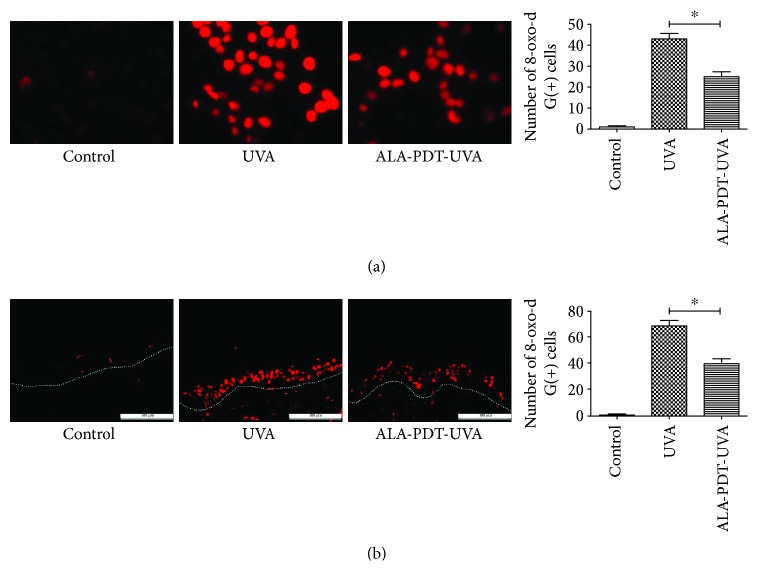
The expression level of 8-oxo-dG was inhibited with ALA-PDT pretreatment. Cells were treated with a sublethal dose of ALA-PDT, then these cells were irradiated with 10 J/cm2 of UVA light. The expression level of 8-oxo-dG was detected by immunofluorescence. (a, b) Red fluorescence represented 8-oxo-dG-positive cells. Photographs were taken randomly under a fluorescence microscope, and the number of positive cells was counted; this represented the data for each group. Data were expressed as mean ± SD, n = 3 for each group, ∗p < 0.05.